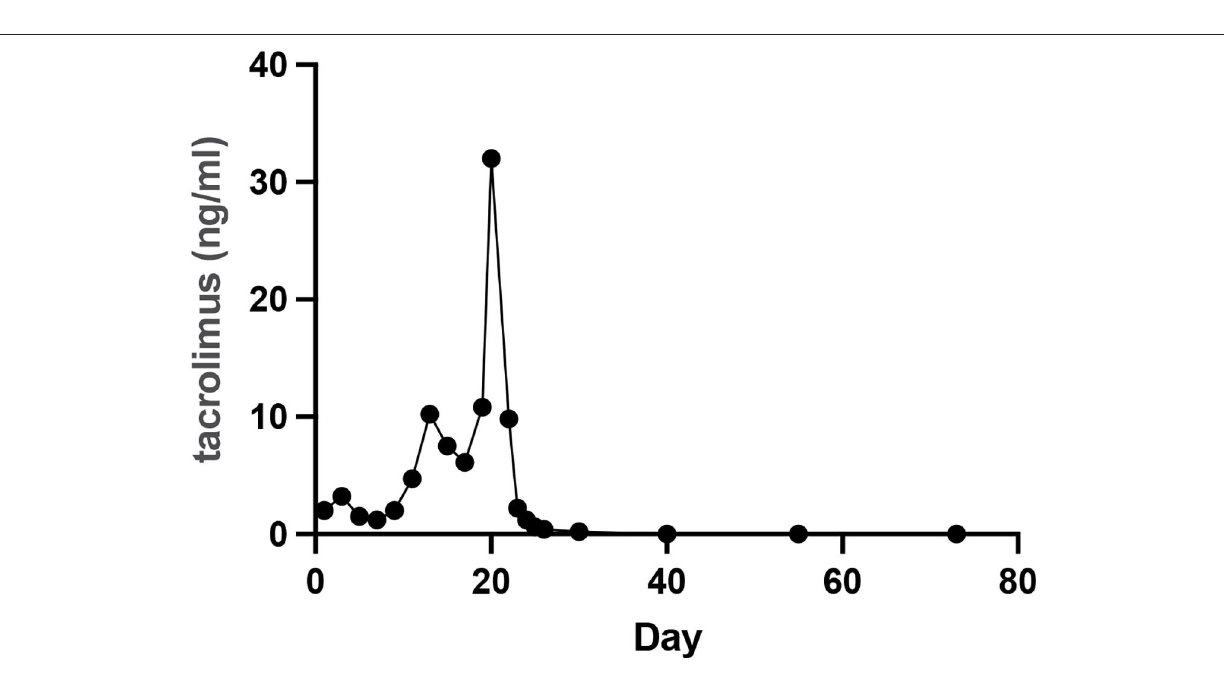
FIGURE 4 | The concentration curve of tacrolimus during the